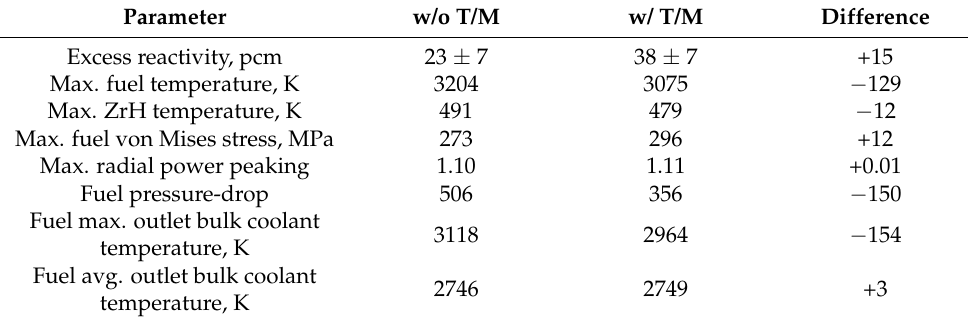
Table 3. Comparison of global